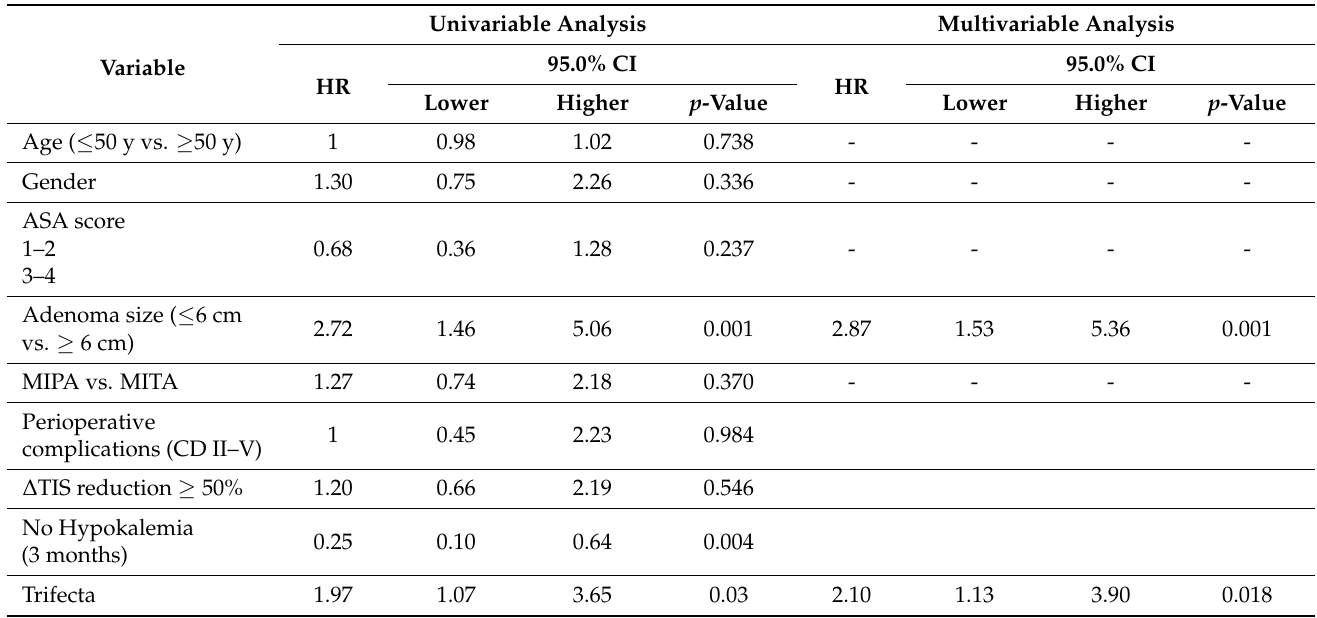
Table 8. Univariable and multivariable logistic regression analysis to identify predictors of complete biochemical success according to PASO